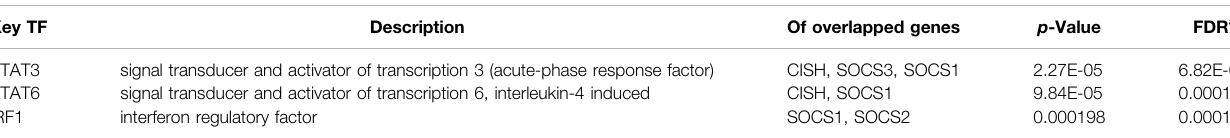
TABLE 2 | Potential transcription factor targets of SOCS family